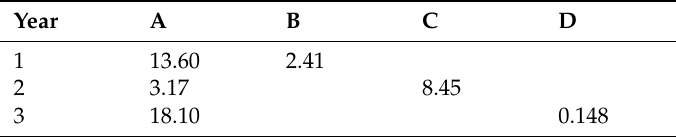
Table 5. Investment strategy II.